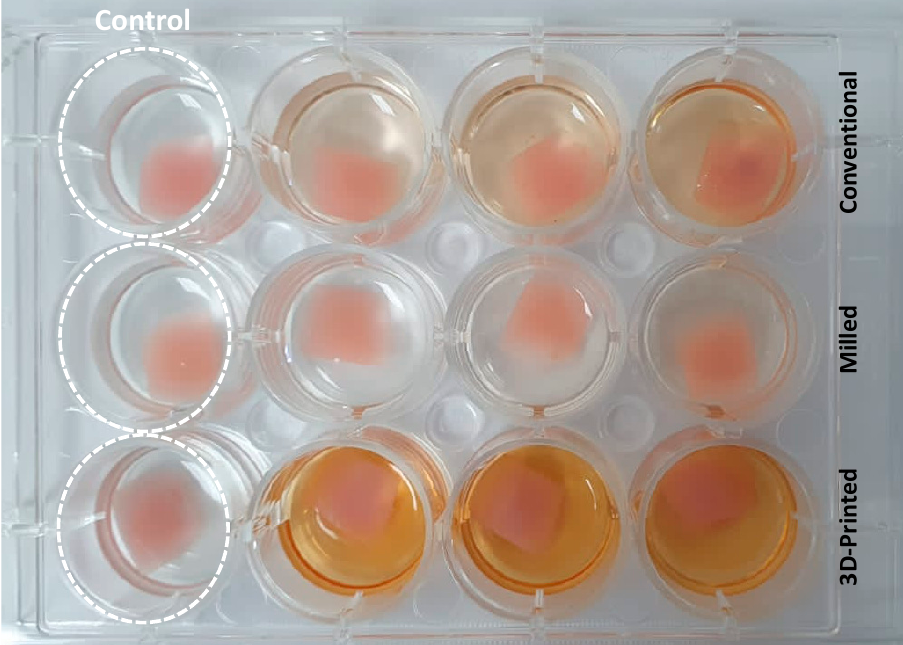
Figure 3. Biofilm quantification of the three test groups (conventional, milled, and 3D-printed groups) in well plates in triplicates after 24 h of incubation with C. albicans using the XTT assay. Control group represents samples from each group kept uninoculated with C. albicans .